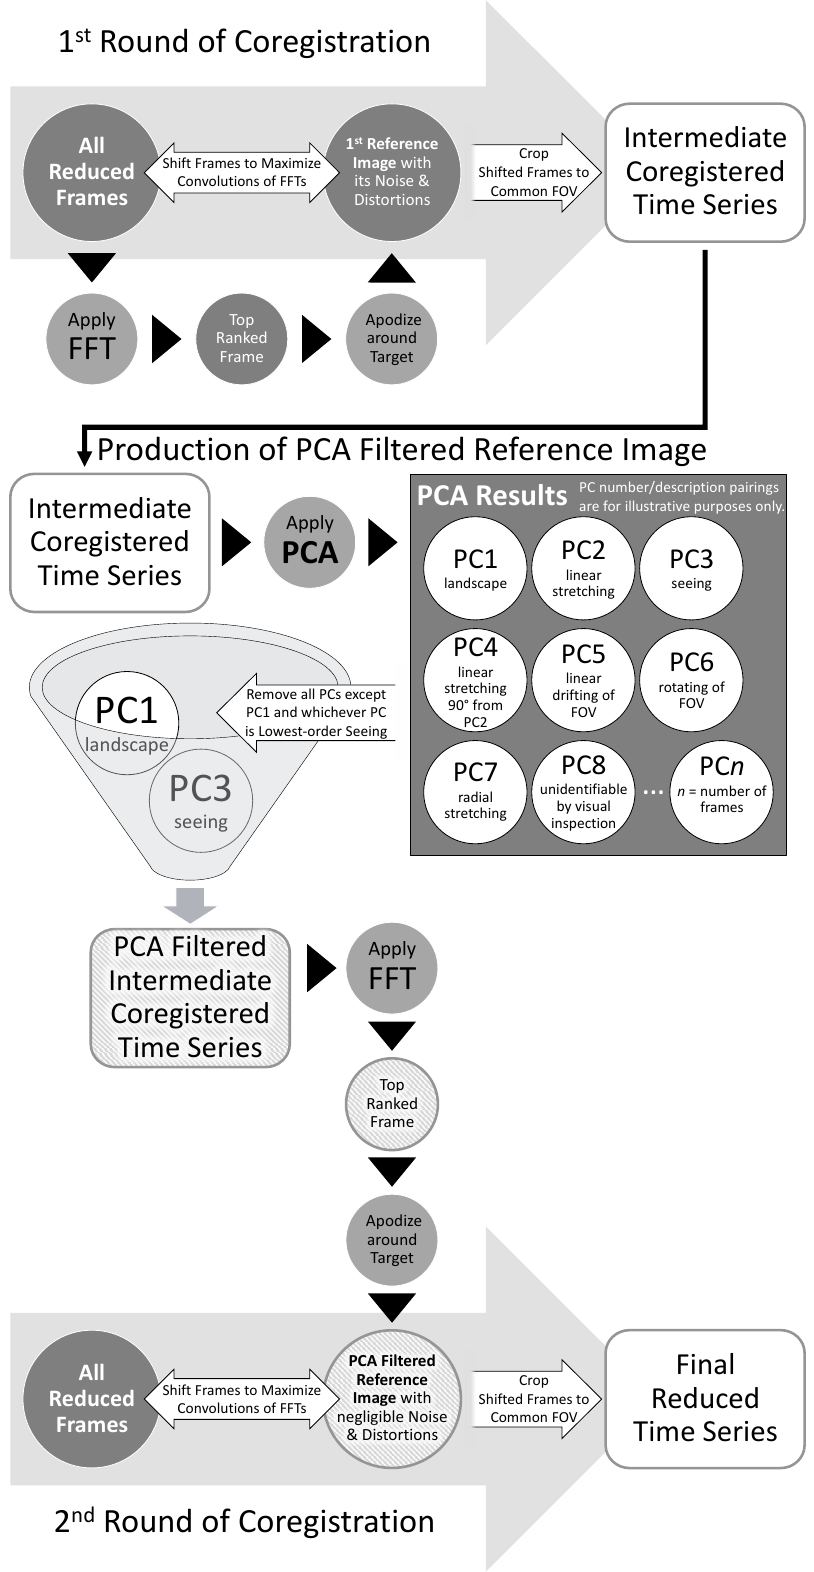
Figure 2. Flowchart of coregistration employing a PCA-filtered reference image. The Python code we developed for this process (coreg_pca in image_cube.py) is available in Zenodo at https://doi.org/